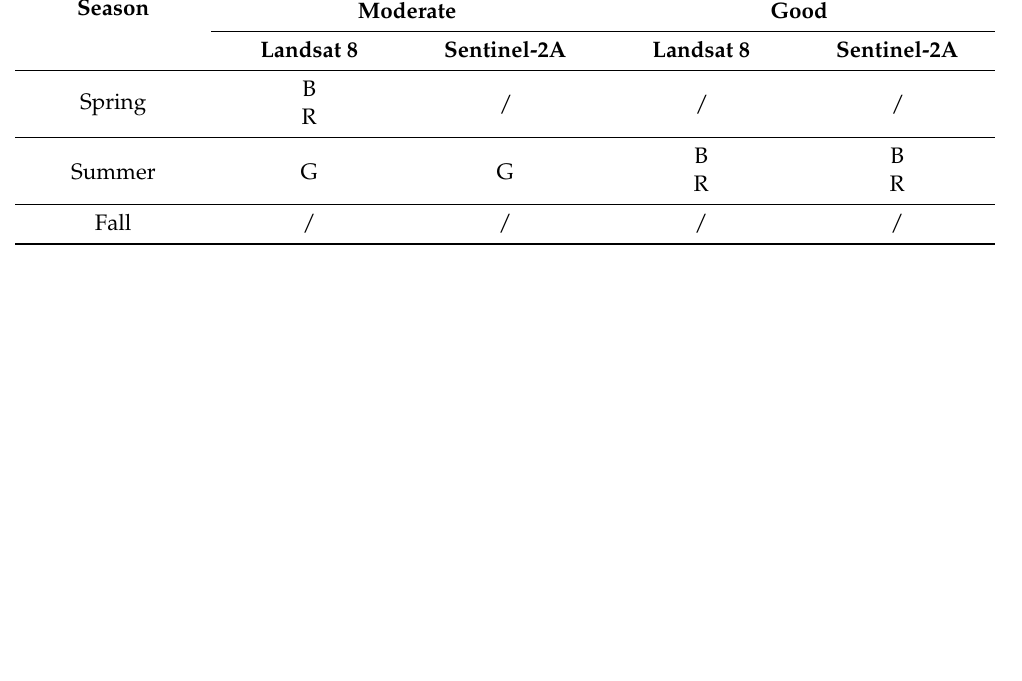
Table 4. Seasonal wavelength bands that offer moderate and good separation between western snowberry and wolfwillow with Landsat 8 and Sentinel-2A simulated data (B = Blue, R = Red, G = Green). Separability between Western Snowberry and Wolfwillow Wavelength Bands Season Moderate Good Landsat 8 Sentinel-2A Landsat 8 Sentinel-2A B Spring / / / R